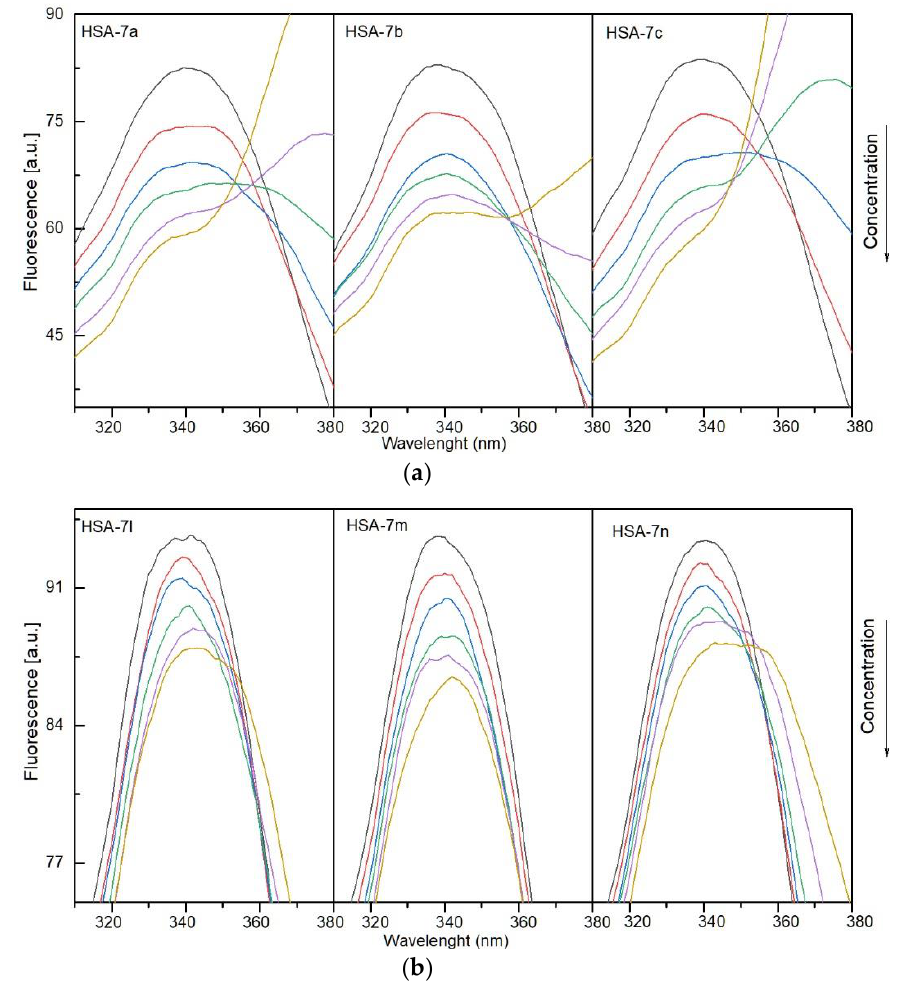
Figure 6. ( a ). Fluorescence quenching spectra of human serum albumin (HSA) in the presence of different concentrations of compounds 7a – 7c (T-297 K, λ ex = 280 nm). The concentration of HSA was 1.0 µM, the concentration of 7a – 7c 0, 0.4, 0.8, 1.2, 1.6, and 2.0 µM. ( b ). Fluorescence quenching spectra of human serum albumin (HSA) in the presence of different concentrations of compounds 7l – 7m . (T-297 K, λ ex = 280 nm). The concentration of HSA was 1.0 µM, the concentration of 7l – 7m 0, 0.4, 0.8, 1.2, 1.6, and 2.0 µM.